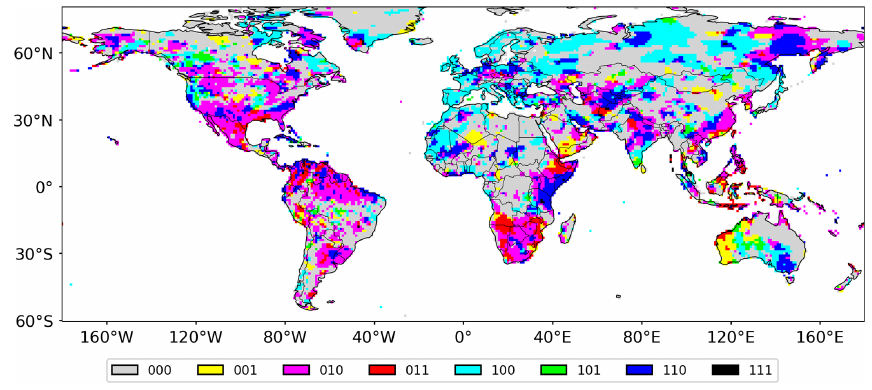
Figure 3. Spatial distribution of the eight patterns of overlapping and differing information.